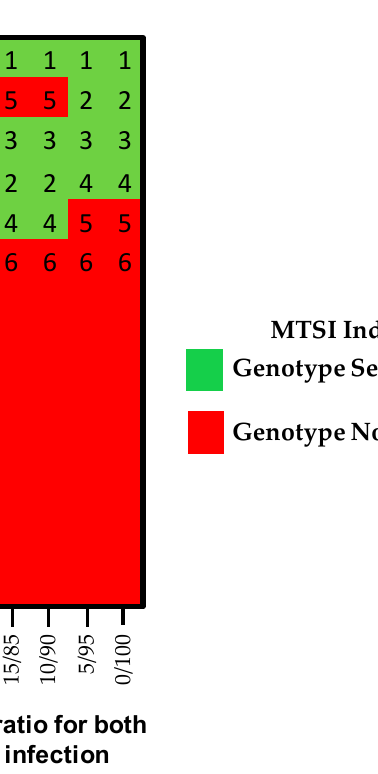
Figure 3. Heatmap showing the MTSI index rank of 14 chickpea genotypes considering different weights for stability and both, GY and ascochyta infection.